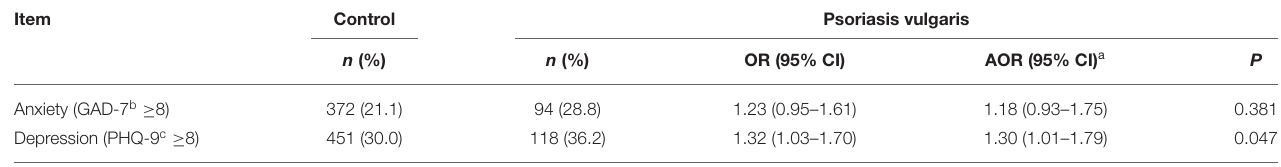
TABLE 2 | The association between depression and anxiety of the participants among two groups based on the questionnaires.